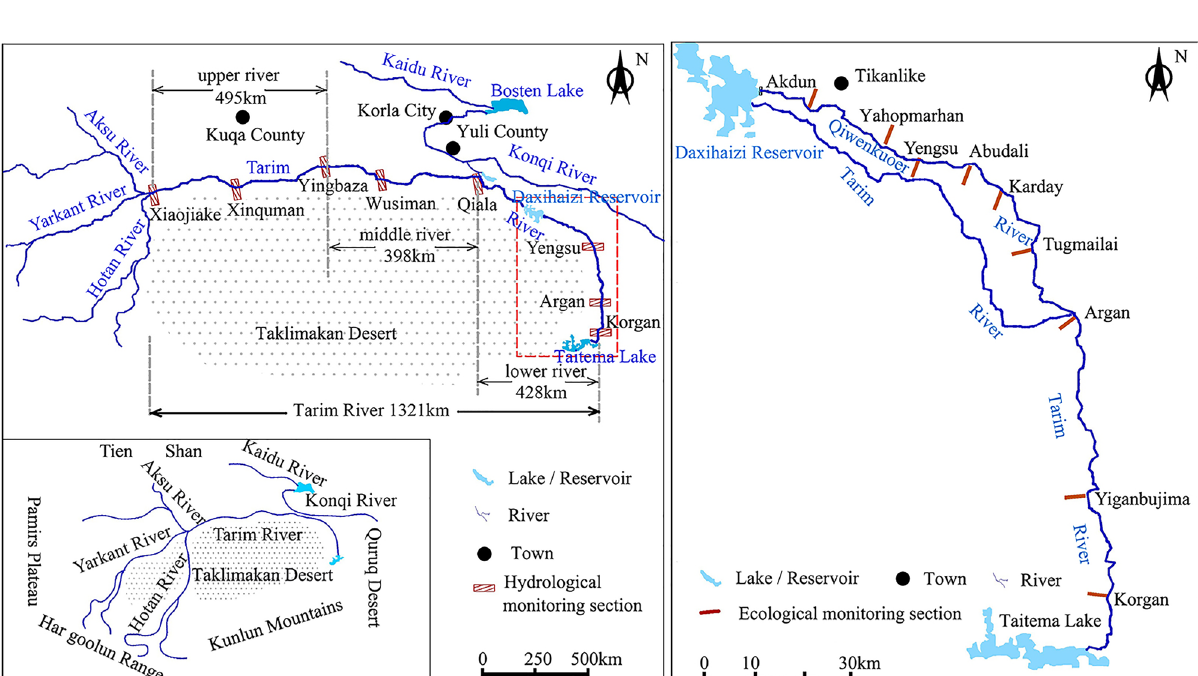
Figure 6. Distribution map of the lower reaches of Tarim River. This map was constructed using ArcGIS 10.3 (http:// www. esri. com/ softw are/ arcgis/ arcgis- for- deskt